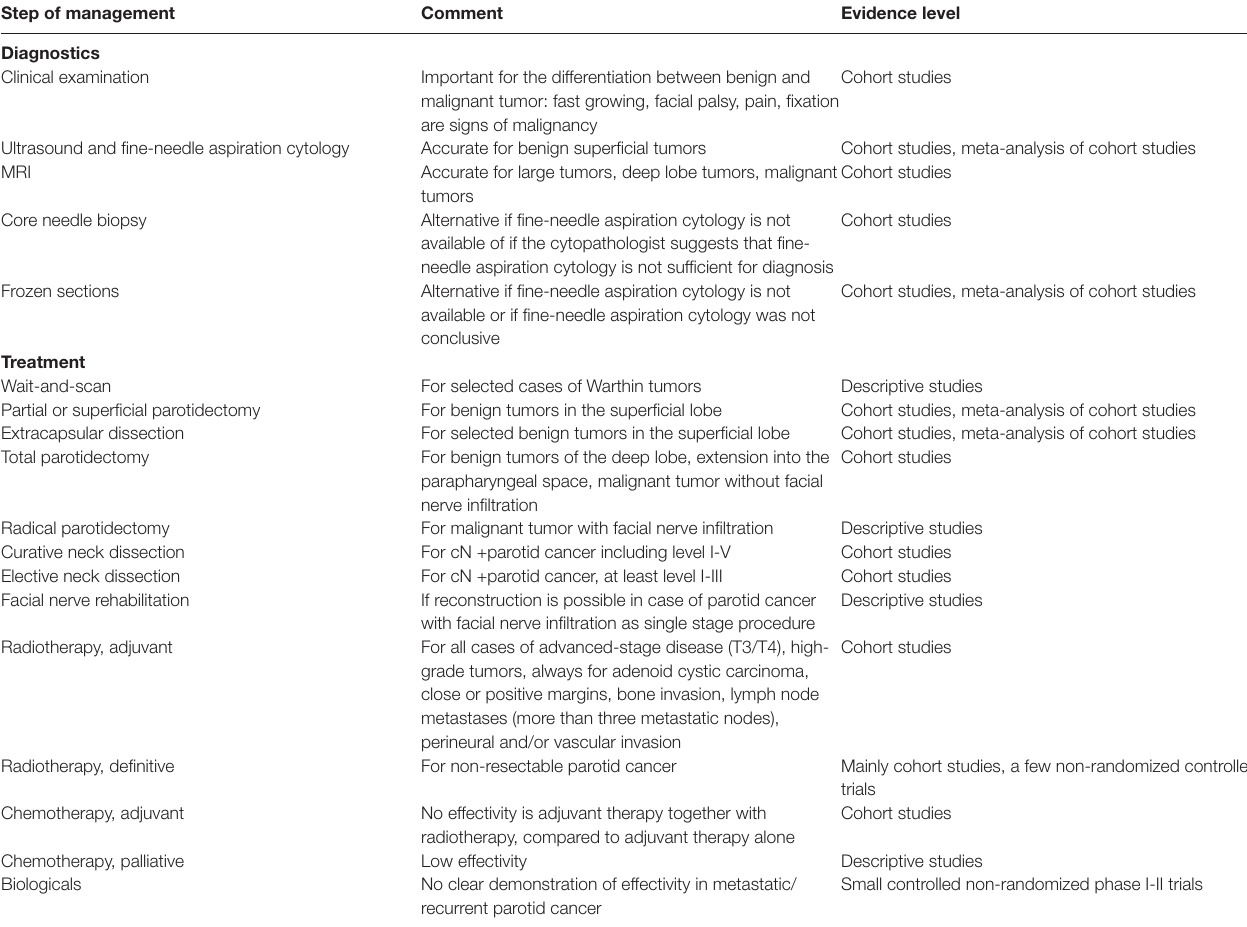
TABle 1 | Management of parotid tumors – levels of